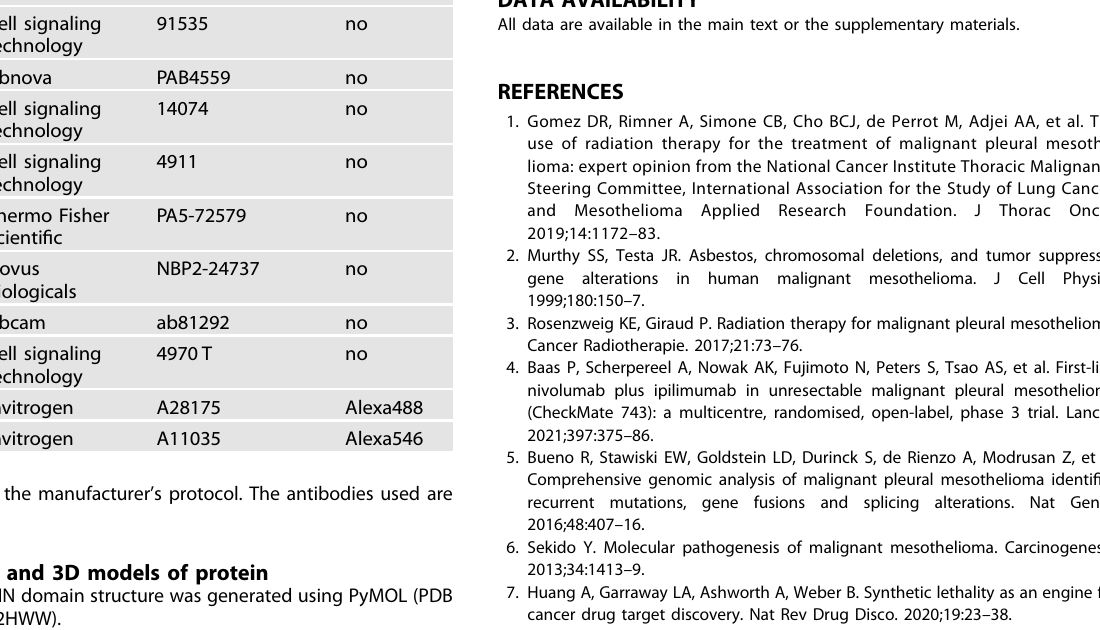
Table 3. List of